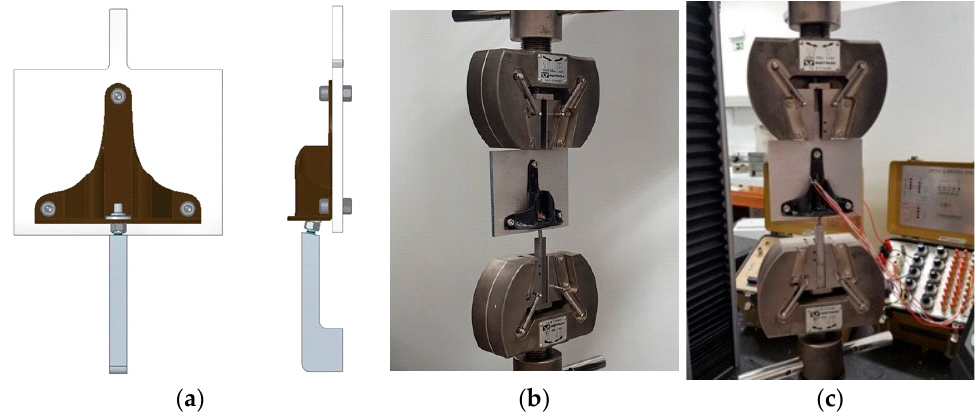
Figure 14. Experimental setup: ( a ) designed setup, ( b ) component A, and ( c ) component